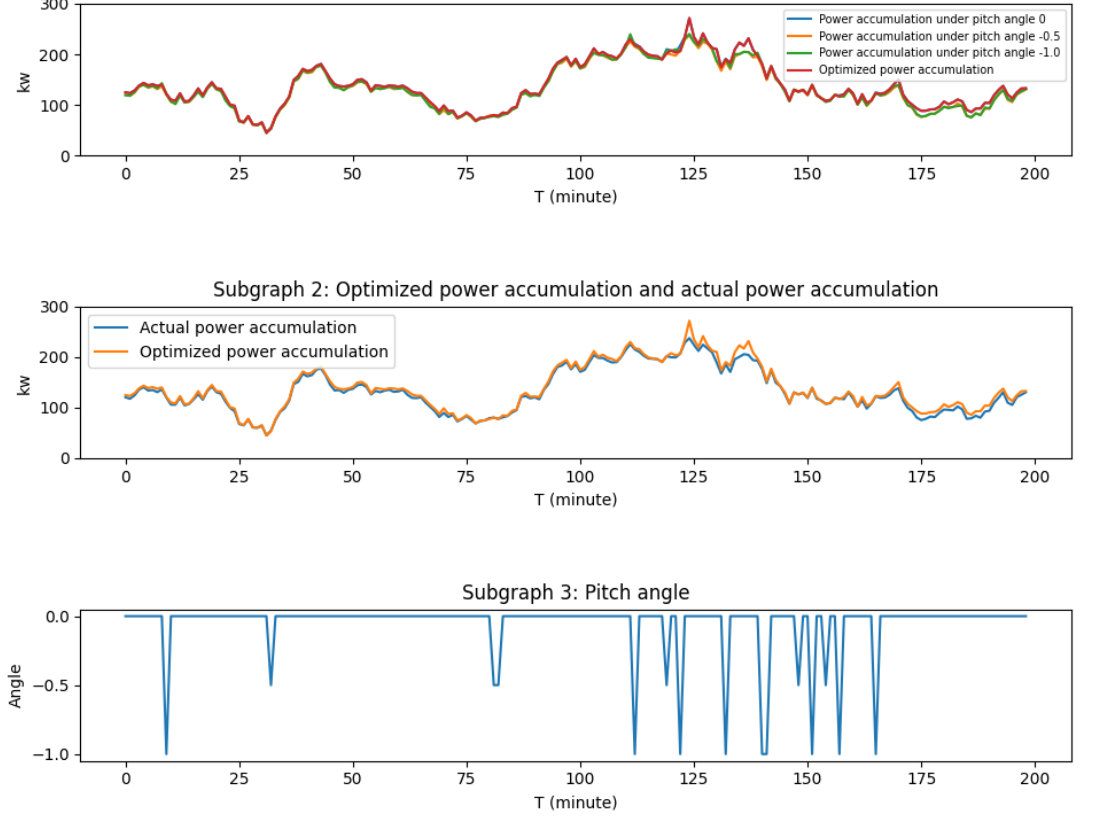
Table 7. Power optimization results on #6 under different period.